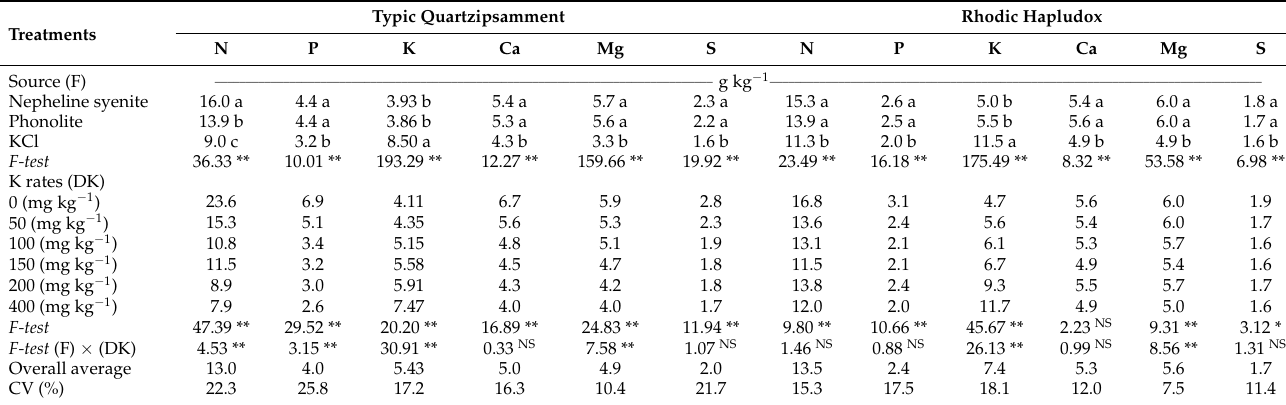
Table 9. Effects of treatments on macronutrient concentrations in the shoot of maize plants grown in the Typic Quartzipsam- ment and in the Rhodic Hapludox, depending on the application of sources and rates of potassium. Treatments